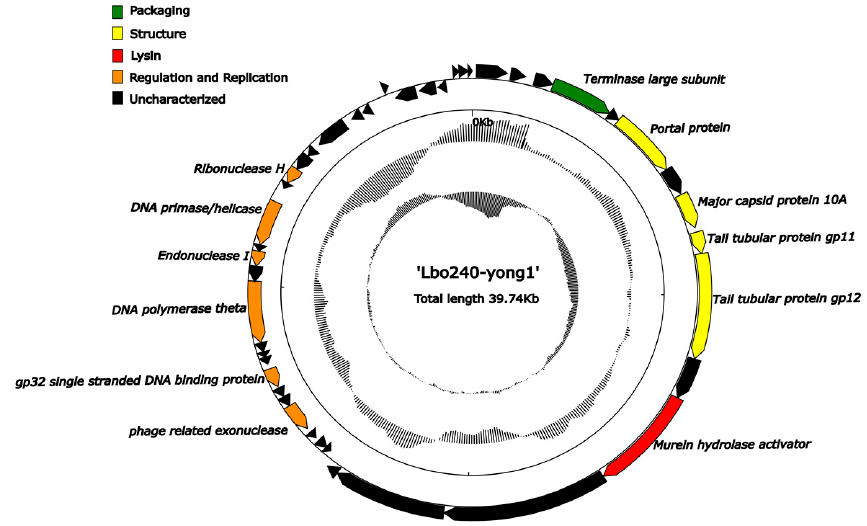
Figure 3. Genome map of cyanophage Lbo240-yong1. The outermost circle represents the 44 ORFs encoded in the genome, with different colors representing different functions (the clockwise arrow indicates the forward reading frame, and the counterclockwise arrow indicates the reverse reading frame); the dark circles in the middle represent the GC content (outwards indicates greater than the average GC content compared with the whole genome, and inwards indicates the opposite); the innermost circle represents the GC skew (G-C/G+C; outwards indicates >0, and inwards indicates <0).